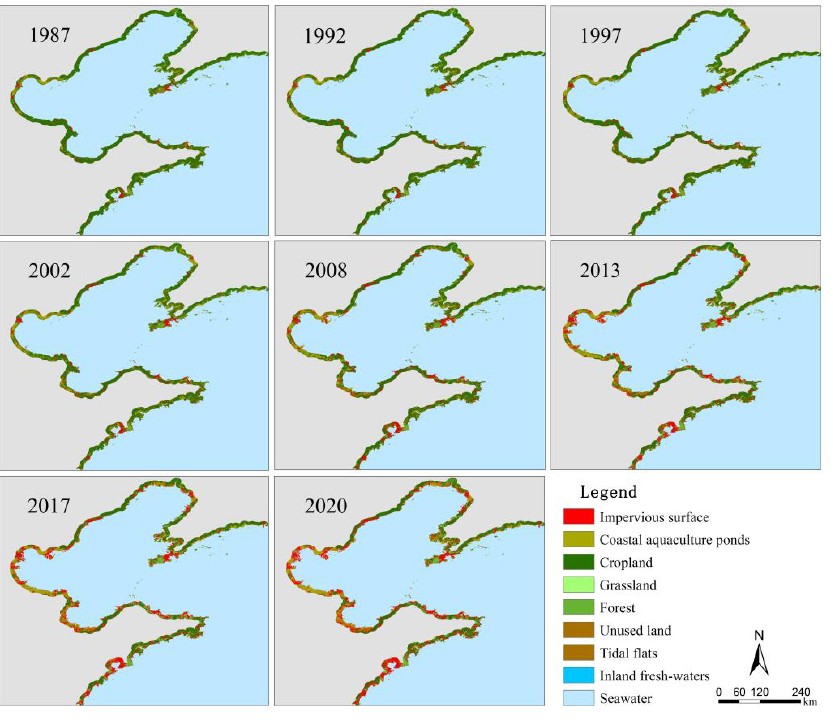
Land 2022 , 11 , x FOR PEER REVIEW Figure 3. Results of long-time-series coastal zone function classification. Figure 3. Results of long-time-series coastal zone function classification.